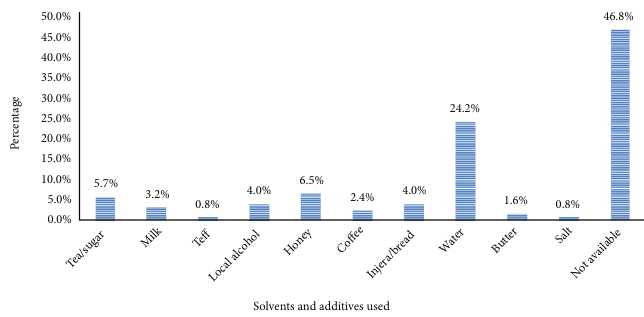
Figure 4: Solvents and additives used by healers for the preparation of remedy in Ethiopia.